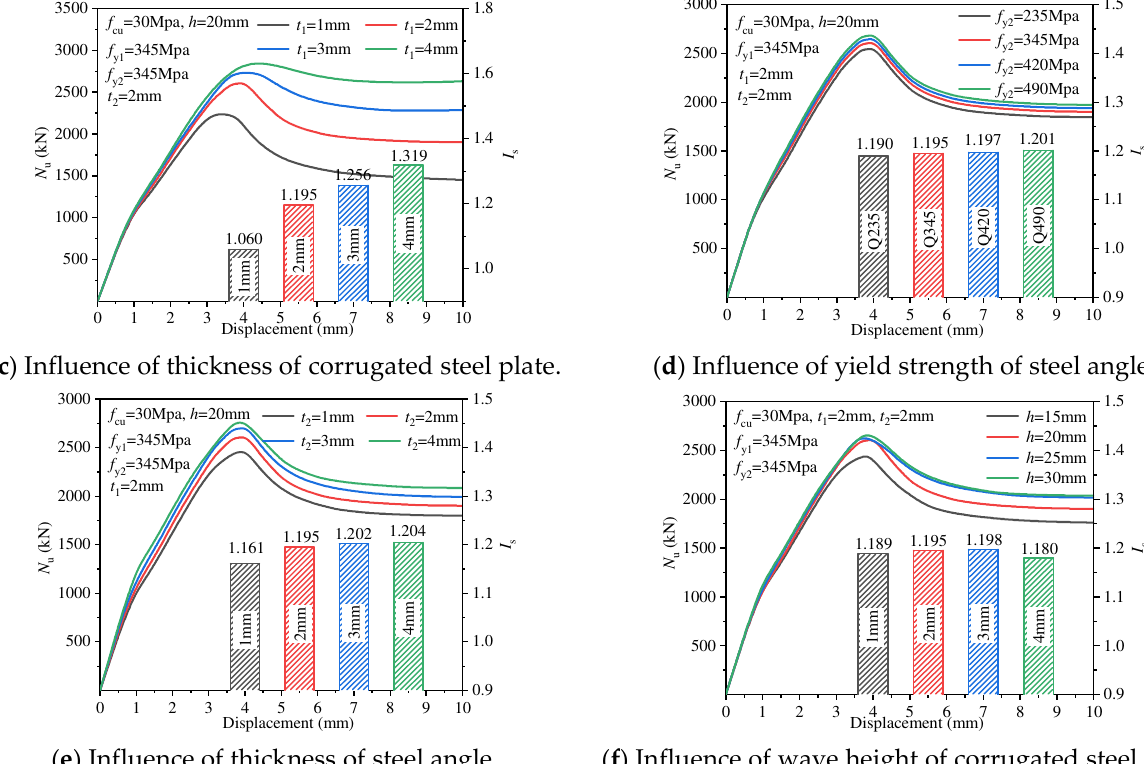
Figure 15. Influence of wave height of corrugated steel plate on N u and I s .